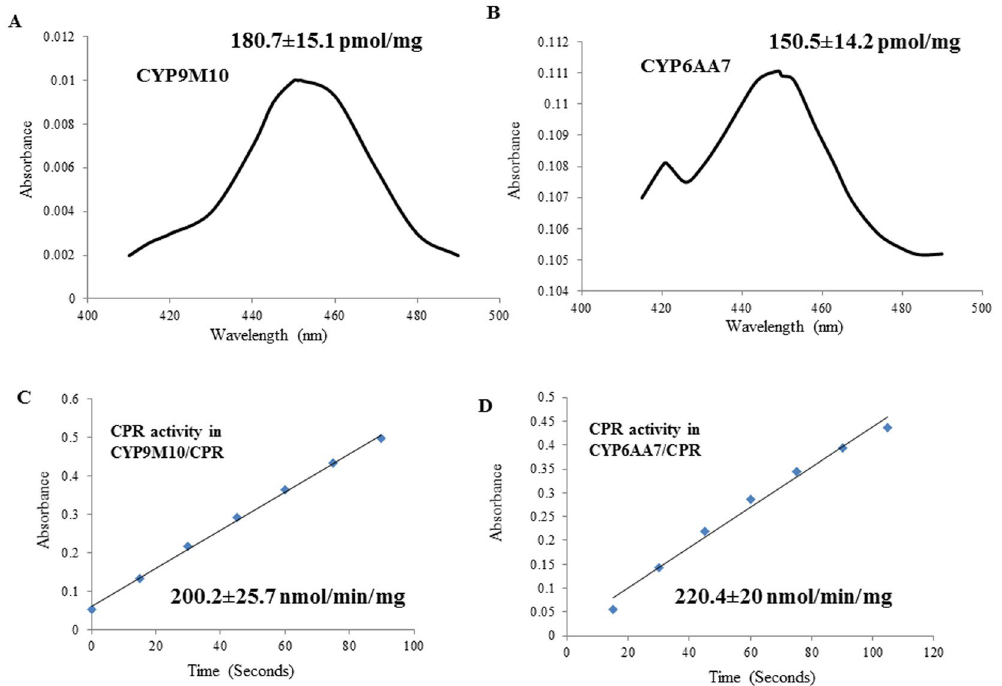
Figure 1. Biochemical characterization of P450 content and CPR activity of co-expressed P450/CPR. ( A ) P450 content detected in microsomal protein of Sf9 cells expressing CYP9M10; ( B ) P450 content detected in microsomal protein of Sf9 cells expressing CYP6AA7; ( C ) CPR activity measured in microsomal protein of Sf9 cells co-expressing CYP9M10/CPR; ( D ) CPR activity measured in microsomal protein of 6AA7/CPR expressing Sf9 cells.